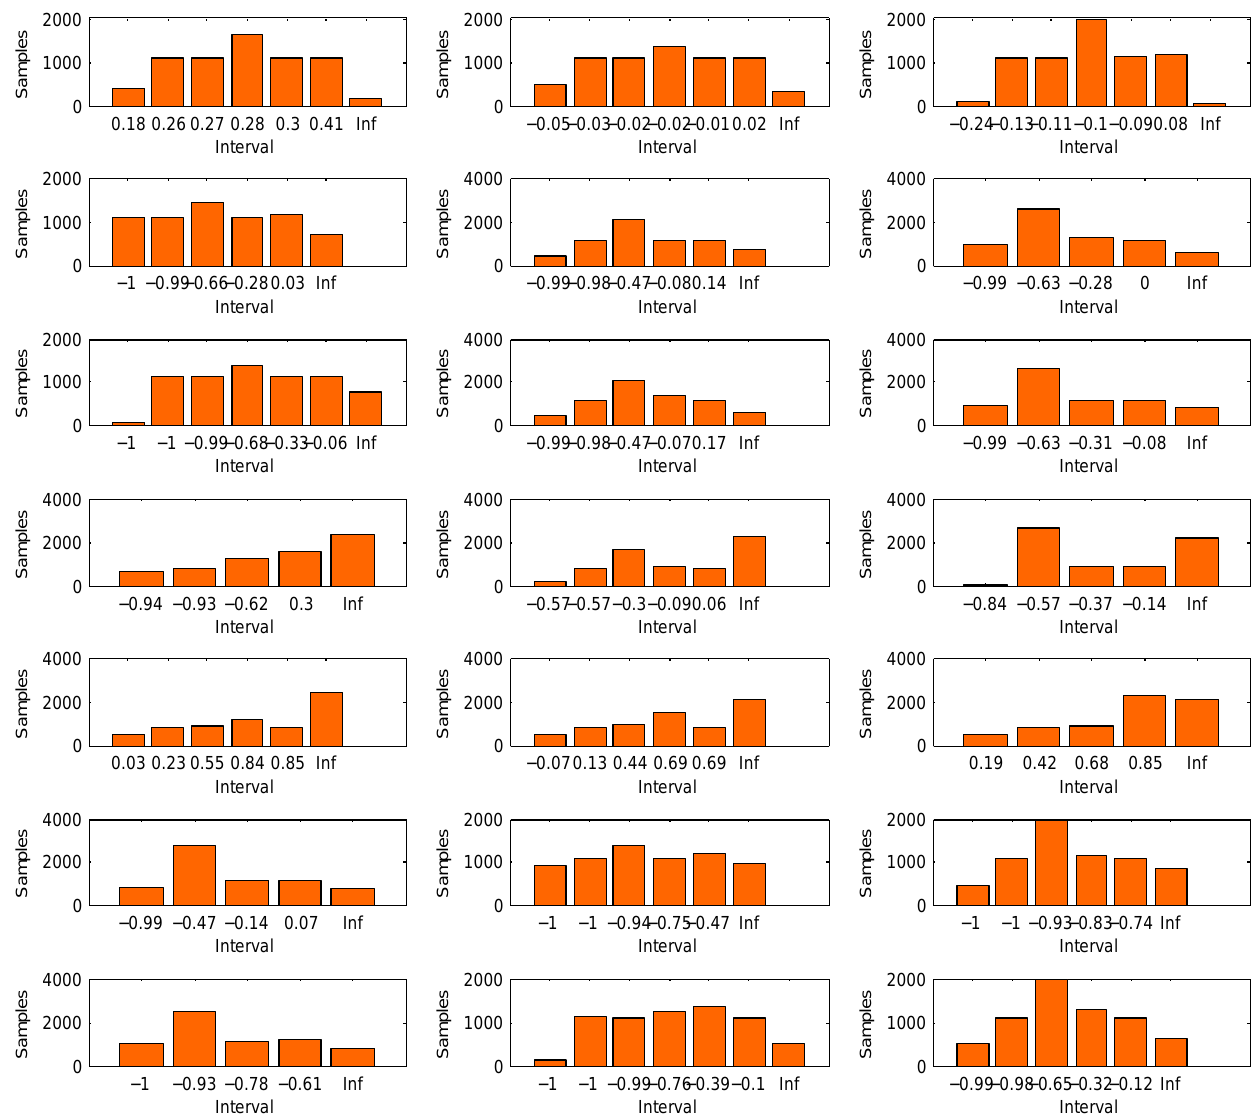
Figure A1. Distribution of instances in each interval for the first 21